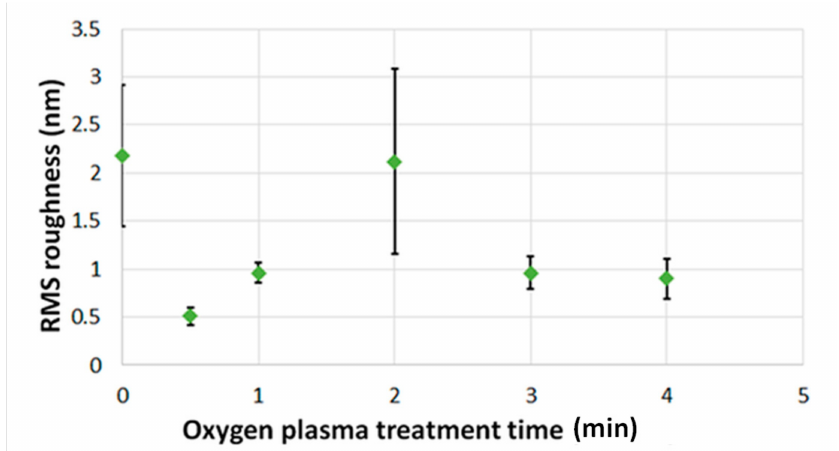
Figure 6. Measured root mean square RMS surface roughness values vs. oxygen plasma exposure time, for the various developed garnet thin